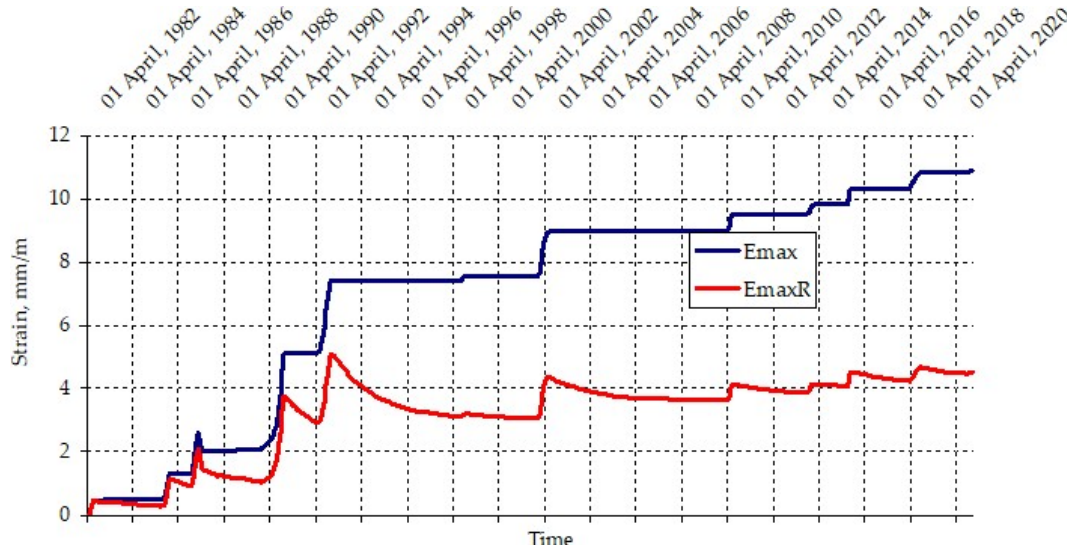
Figure 15. The course of the maximum horizontal strain with consideration of the so-called “relax- ation” ( ε maxR ), according to Białek (2003) [53], and without taking it into account ( ε max ) [2], with the assumption of the immediate manifestation of impacts.